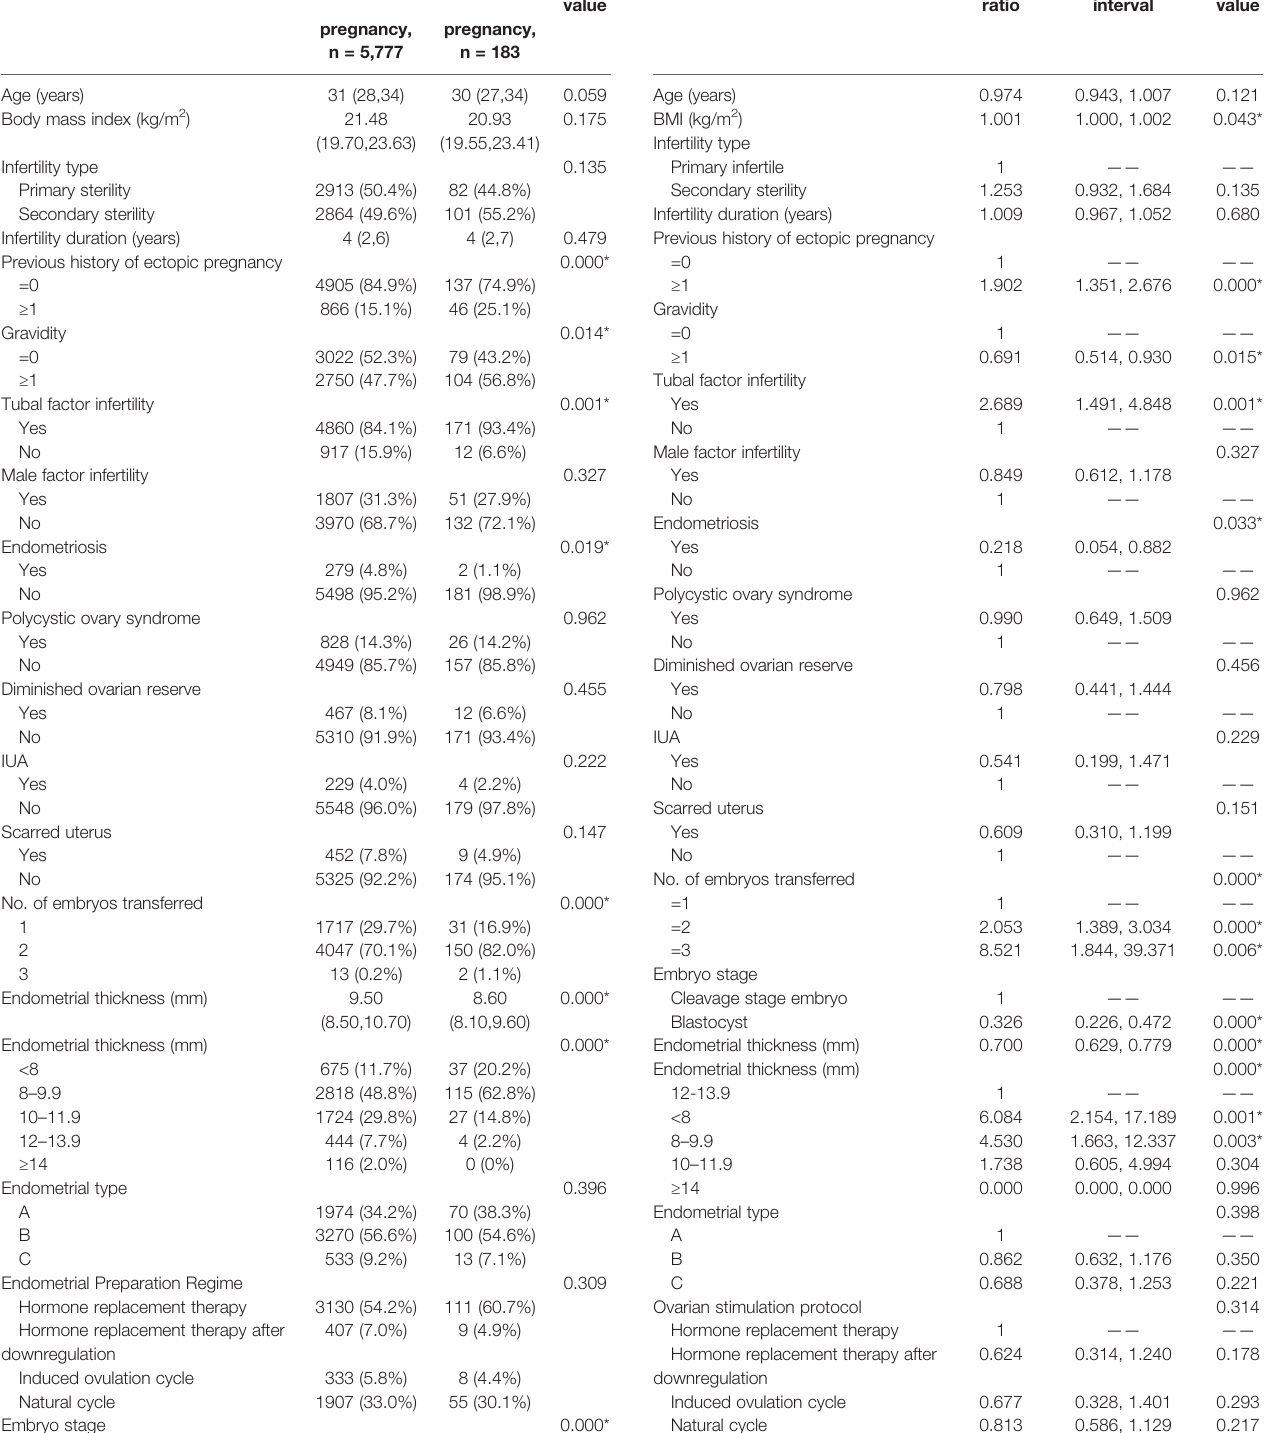
*The difference is signi fi cant between the two